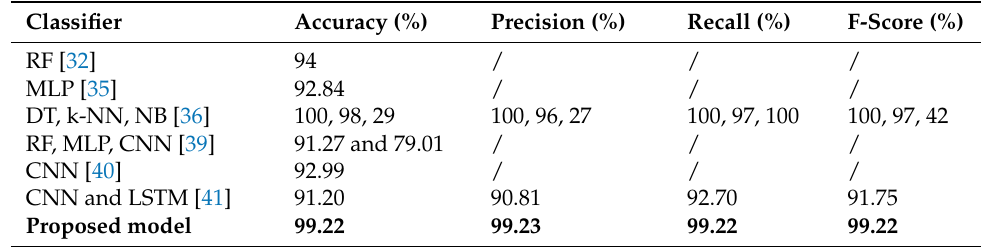
Table 8. Performance comparison with previous